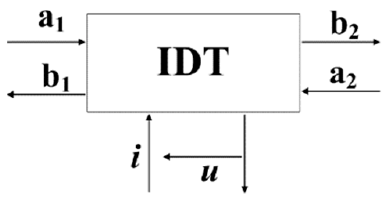
Figure 7. The P matrix model of an IDT. Differing from IDT, the P matrices of the free waveguide layer and waveguide layer with micro piezoelectric PnCs transmitting paths can be reduced to two acoustical ports, as shown in the following equation: